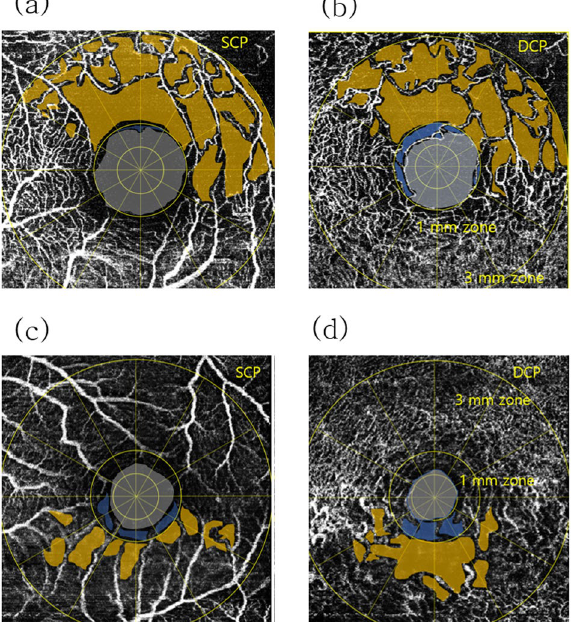
Figure 2. Schematic nonperfusion area (NPA) images from ( a , b ) a 62-year-old female patient from the recurrence group and ( c , d ) a 61-year-old female patient from the nonrecurrence group. Nonperfusion area 3 (NPA3) was defined as the capillary dropout area plus the dark or gray areas with a hypointense hue within the 3-mm zone (excluding the 1-mm zone). The foveal avascular zone (FAZ) was defined as an area within the innermost ring of the parafoveal capillaries if the FAZ border was clear. ( a–d ) Nonperfusion area 1 (NPA1) of the DCP was defined as the FAZ plus the nonperfusion area in the 1-mm zone. The NPA3s of ( a ) the SCP and ( b ) the DCP in recurrence cases were delineated as the yellow area. The NPA1s of ( a ) the SCP and ( b ) the DCP in a recurrence case were defined as the FAZ (gray area) plus microvascular nonperfusion area (blue area) in the 1-mm zone. ( c ) The NPA3 of the SCP and ( d ) DCP in a nonrecurrence case was also delineated as the yellow area. The NPA1s of ( c ) the SCP and ( d ) the DCP in this nonrecurrence case were also defined as the FAZ (gray area) plus microvascular nonperfusion area (blue area) in the 1-mm